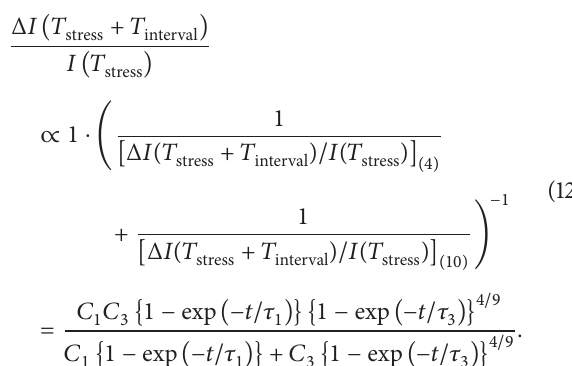
Figure 6: Time evolution of gate current (Δ𝐼(𝑇 (𝑇 )) after a single stress application. The CCS condition 𝐼 stress stress is 500 mA/cm 2 in all experiments. 𝑄 stress is 6 C/cm 2 or 12C/cm 2 . Symbols are measured results, and lines are the results calculated using (12). The characteristic time constant ( 𝜏 3 ) is 3.0 × 10 6 sec for 𝑄 = 6C/cm 2 and 1.5 × 10 6 sec for 𝑄 stress